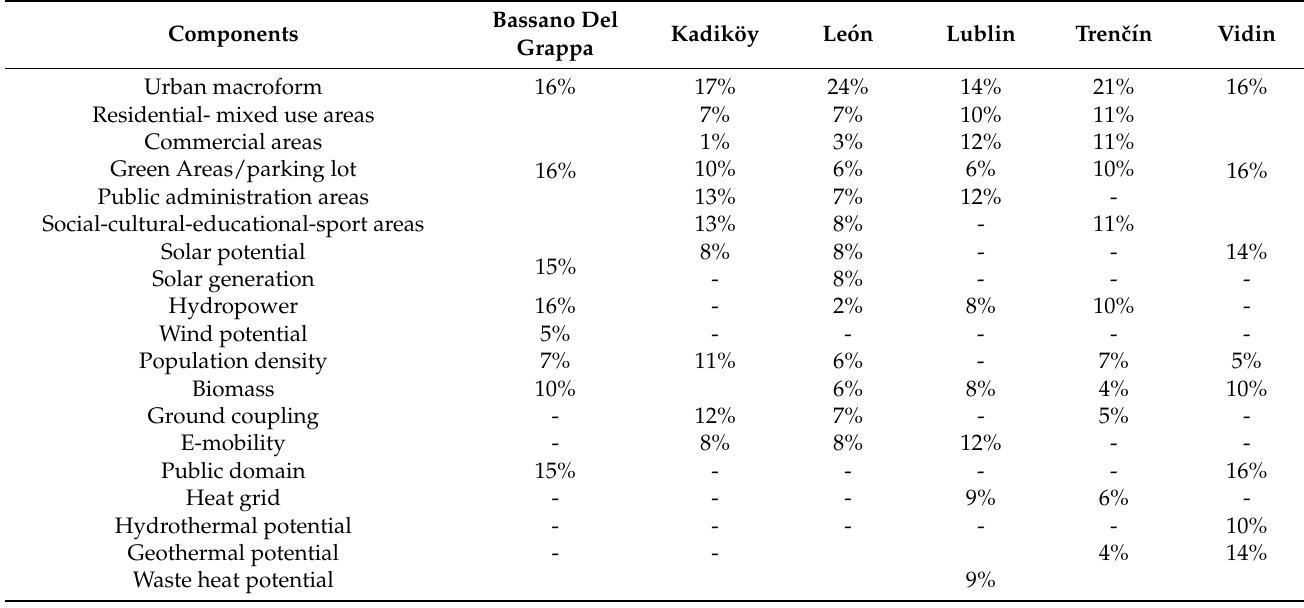
Table 17. Selected GIS layers and prioritization values considered in the analysis of each city.